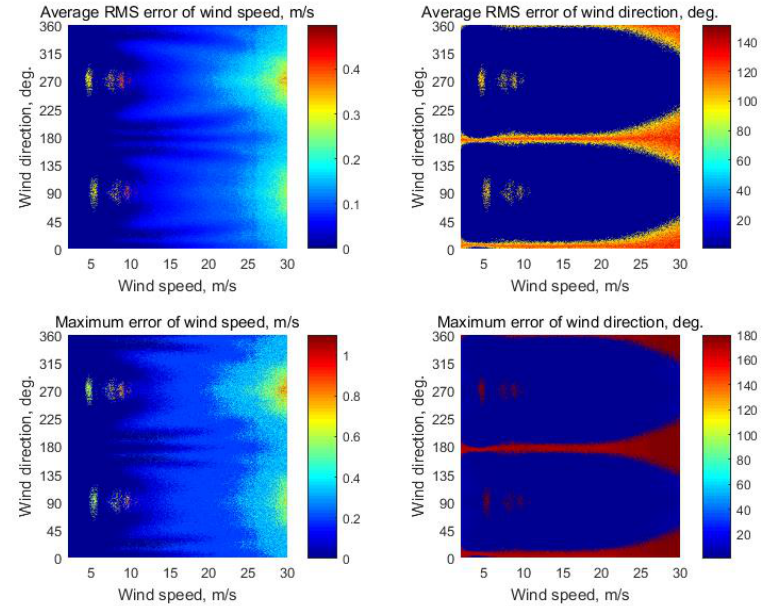
Figure 5. Simulation results for the classical three fan-beam geometry at the wind speeds of 2–30 m/s with 9613 averaged NRCS samples for each combination of the incidence and azimuthal angles.